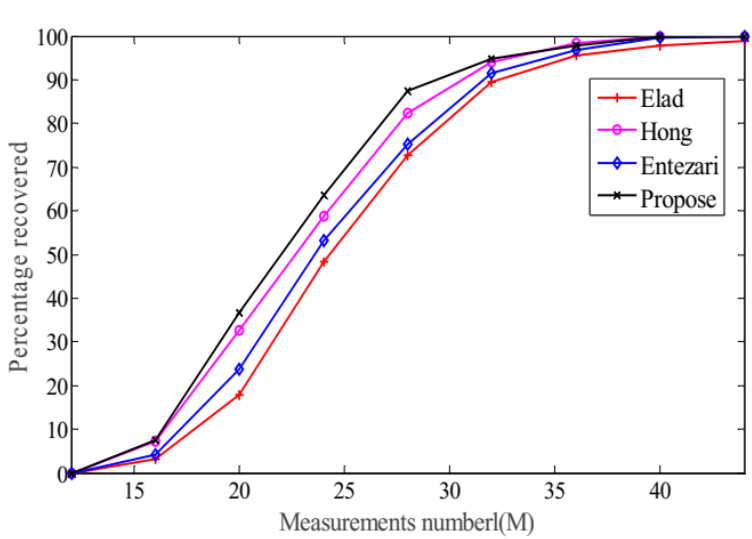
Figure 4. The change tendency of P suc with M while K = 8 in the noiseless case.